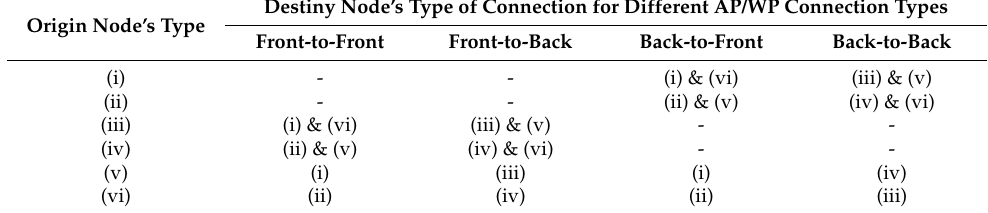
Table 1. TMM’s connection rules for connections within the same TM node. Origin Node’s Type Front-to-Front